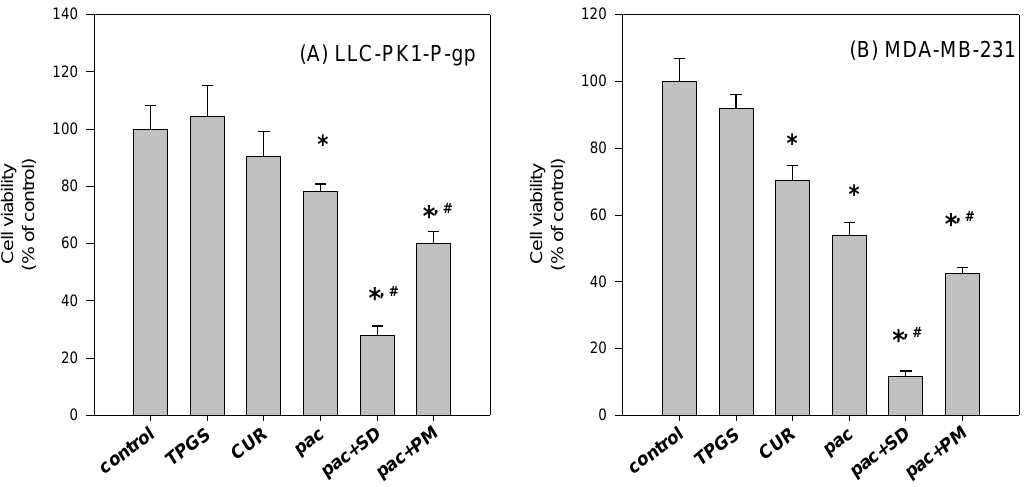
Figure 10. The differential anti-proliferative effect of solid dispersion formulation from physical mixture in LLC-PK1-P-gp ( A ) and MDA-MB-231 cells ( B ). LLC-PK1-P-gp and MDA-MB-231 cells were grown in 96 well plates (10 4 cells/well) and incubated with paclitaxel (pac; 500 nM) in the absence and presence of solid dispersion (SD; curcumin:TPGS:mannitol = 0.09:0.9:1.35 mg/mL), and physical mixture (PM) for 2 h. For comparison, curcumin (CUR; 0.09 mg/mL) and TPGS (0.9 mg/mL) were also incubated for 2 h. After the 2 h incubation, the medium was replaced with fresh medium and incubated for 22 h. MTT assay was performed after 24 h incubation. * p < 0.01, statistically significant compared with control group. # p < 0.01, statistically significant compared with paclitaxel treatment.